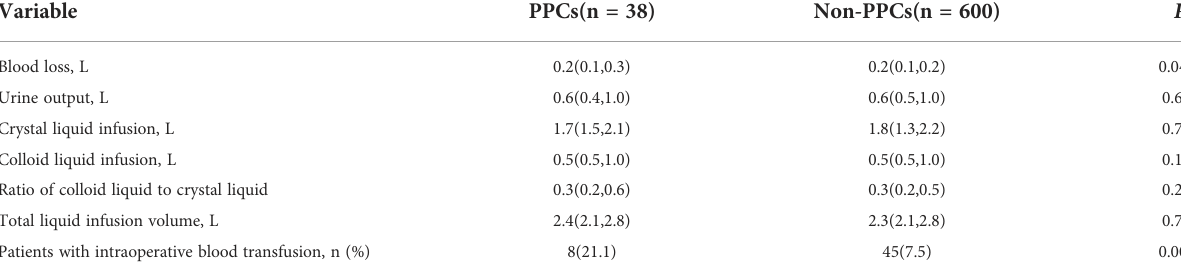
TABLE 3 Perioperative fl uid and blood management in patients.